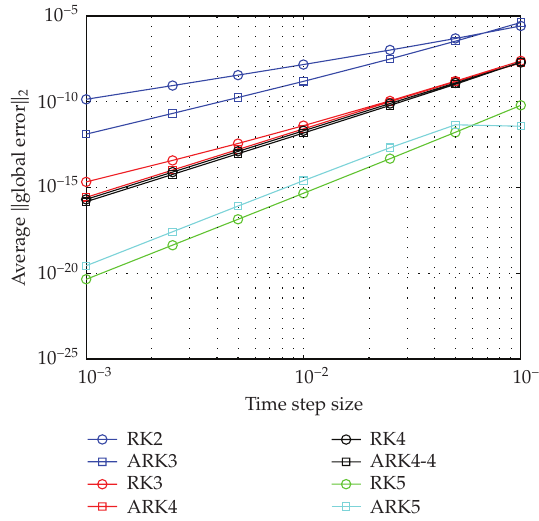
Figure 3: Accuracy plot for IVP-2 (cid:4) see caption of Figure 2 (cid:5)